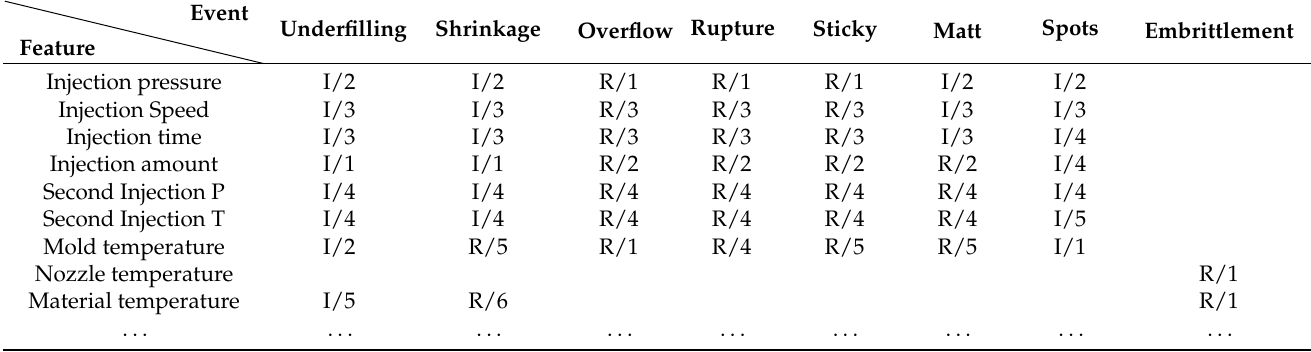
Table 1. The relationship between PLC panel features and corresponding